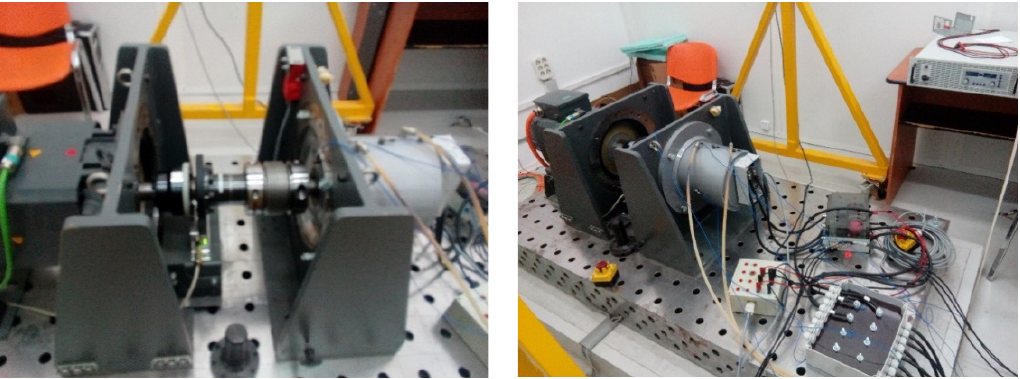
Figure 8. Mechanical coupling of the SynRM with induction machine ( left ), SynRM in a test bench ( right ) . Table 2. SynRM’s main dimensions .